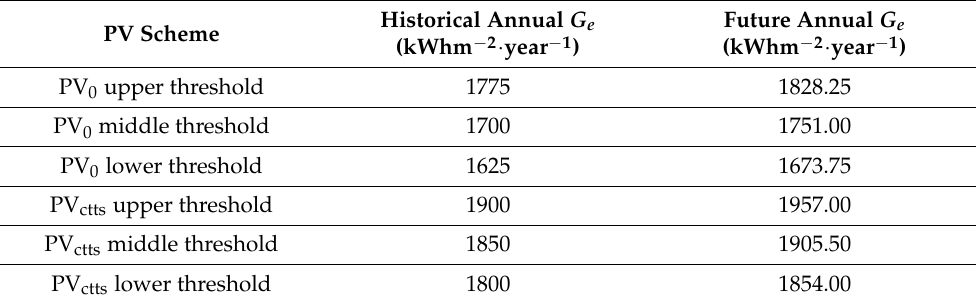
Table 7. Change of the PV 0 and PV ctts thresholds from their historical (this study) values to the new values in the time period of 2010–2080 due to the impact of climate change. The future values are the historical ones increased by 3% on average, according to